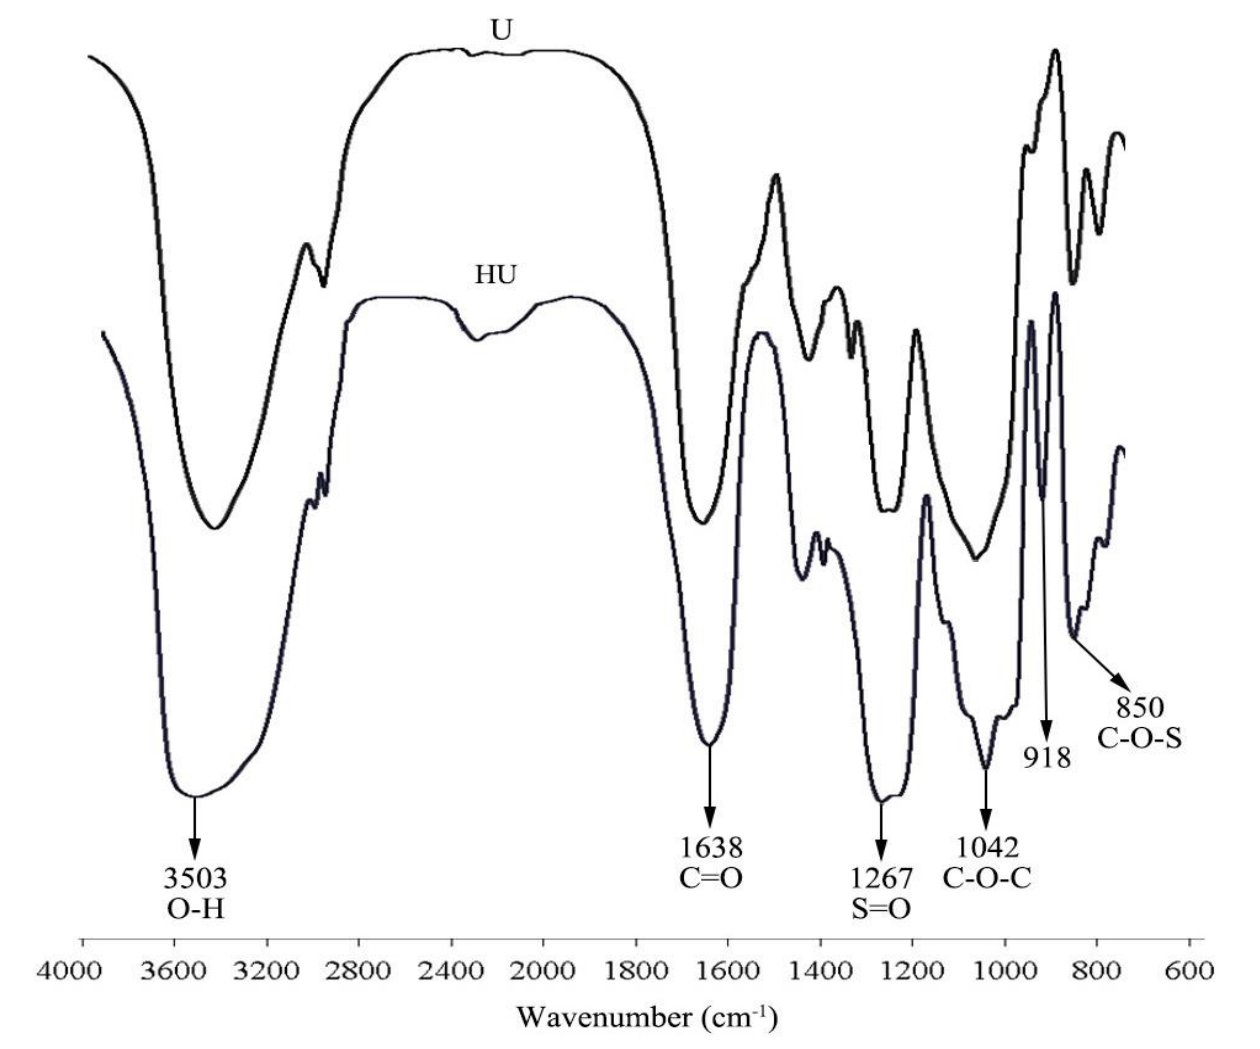
Figure 1. FT-IR spectrum of U and HU.